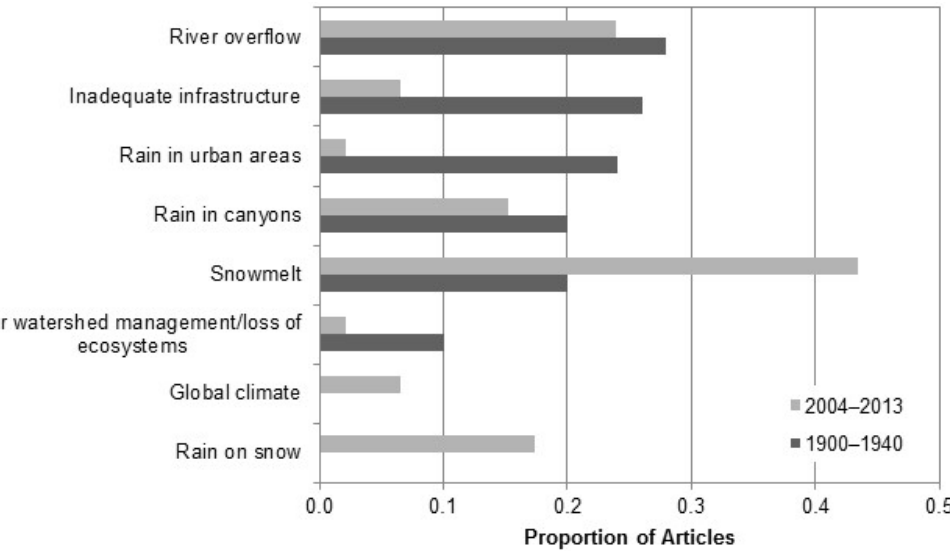
Figure 5. Causes of flooding and stormwater problems during two periods as mentioned in the Salt Lake City news media.